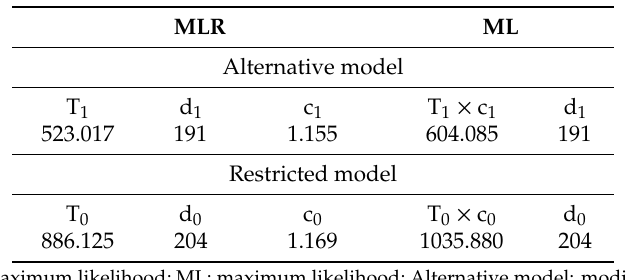
Table 5. Calculating the scaled di ff erence in chi-square for nested model comparison using the robust estimator